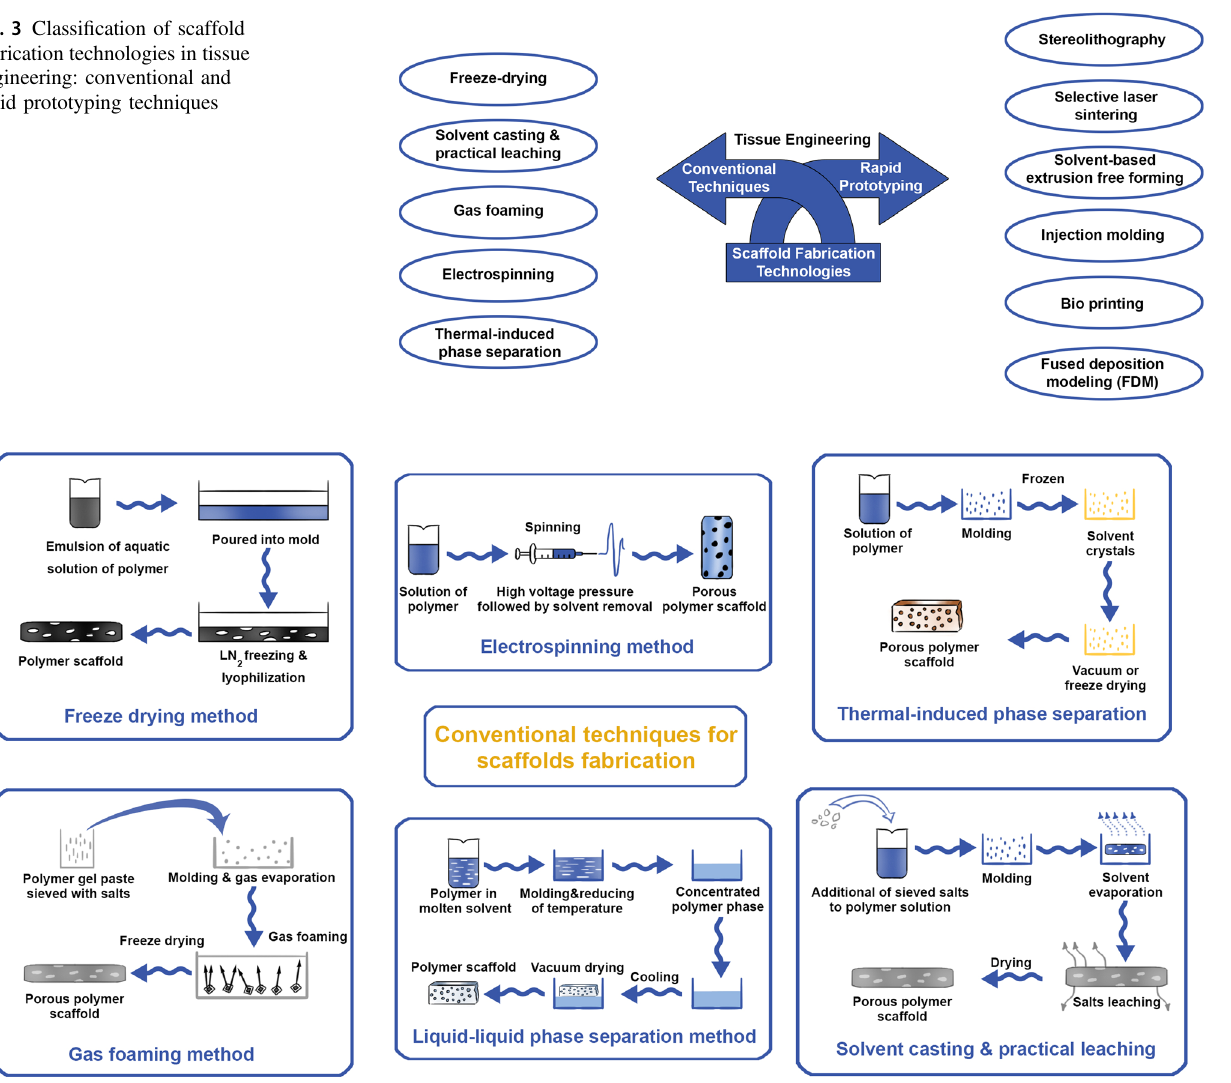
Fig. 4 Schematic illustration of conventional techniques in scaffold